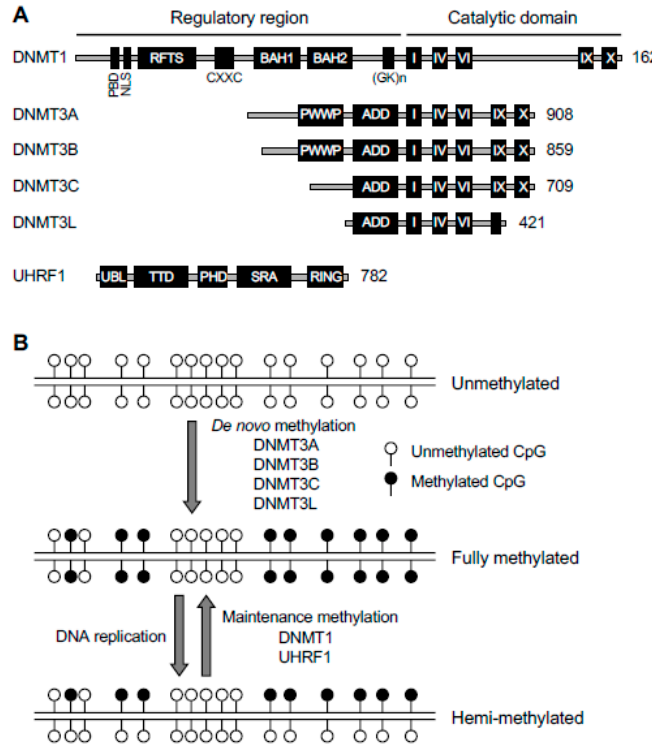
Figure 2. DNA methylation machinery. ( A ) The protein domains in DNA methyltransferases (DNMTs) and ubiquitin − like with plant homeodomain (PHD) and really interesting new gene (RING) finger domains 1 (UHRF1) are shown (the sizes/amino acid numbers refer to mouse proteins). The DNMT1 and DNMT3 families of proteins share conserved catalytic motifs (I–X) in the C-terminal catalytic domains (DNMT3L lacks catalytic activity because some essential motifs are missing or mutated) but have distinct N-terminal regulatory regions. PBD, proliferating cell nuclear antigen (PCNA)-binding domain; NLS, nuclear localization signal; RFTS, replication foci targeting sequence; CXXC, a cysteine-rich zinc finger domain; BAH, bromo-adjacent homology domain; (GK)n, glycine/lysine repeats; PWWP, proline-tryptophan-tryptophan-proline domain; ADD, ATRX-DNMT3-DNMT3L domain; UBL, ubiquitin-like domain; TTD, tandem Tudor domain;